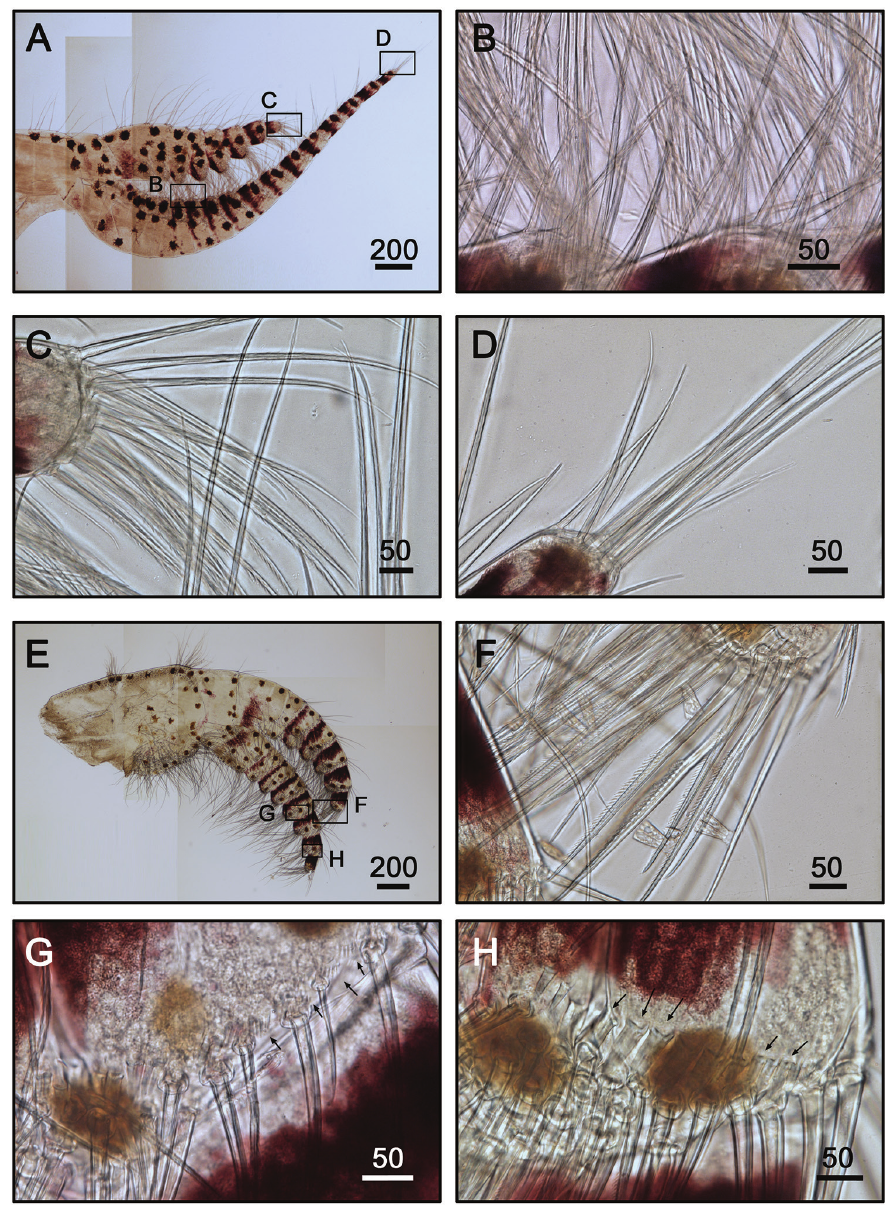
Figure 7. Cirrus I, II of Galkinius maculosus sp. n. A Cirrus I with dark spots, posterior ramus shorter than anterior one (ASIZCR000343) B Serrulate setae on anterior ramus C Simple and serrulate setae on the distal segment of posterior ramus D Simple and bidentate serrulate setae on the distal segment of anterior ramus E Cirrus II with dark spots and stripes on each segment, rami almost equal length (ASIZCR000343) F Simple and bidentate serrulate setae on the distal segment of anterior ramus G Fan-shaped denticles at the margins of middle segment (indicated by arrows) H Series of conical spines at the margin of distal seg- ments (indicated by arrows). Scale bars in